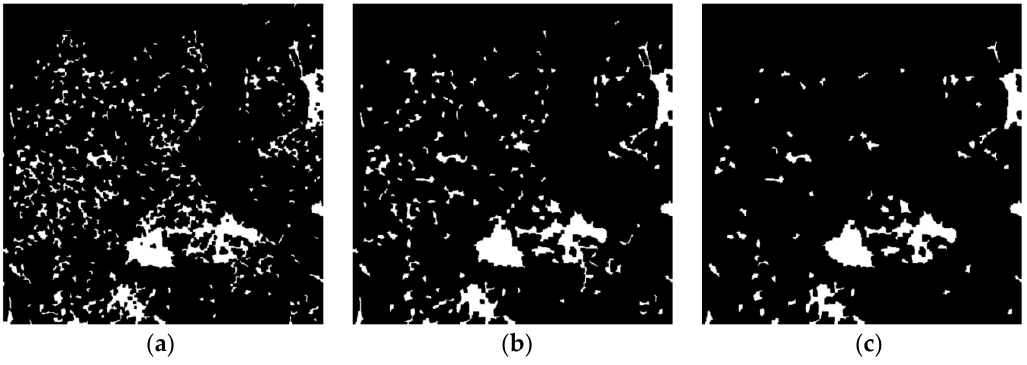
Figure 14. Image differencing results between normalized subject image generated by RF regression and reference image: ( a ) noise reduction using SLIC 5 × 5; ( b ) noise reduction using SLIC 7 × 7; and ( c ) noise reduction using SLIC 9 × 9. Table 6. Quantitative change detection result based on user’s accuracy, producer’s accuracy and overall accuracy.